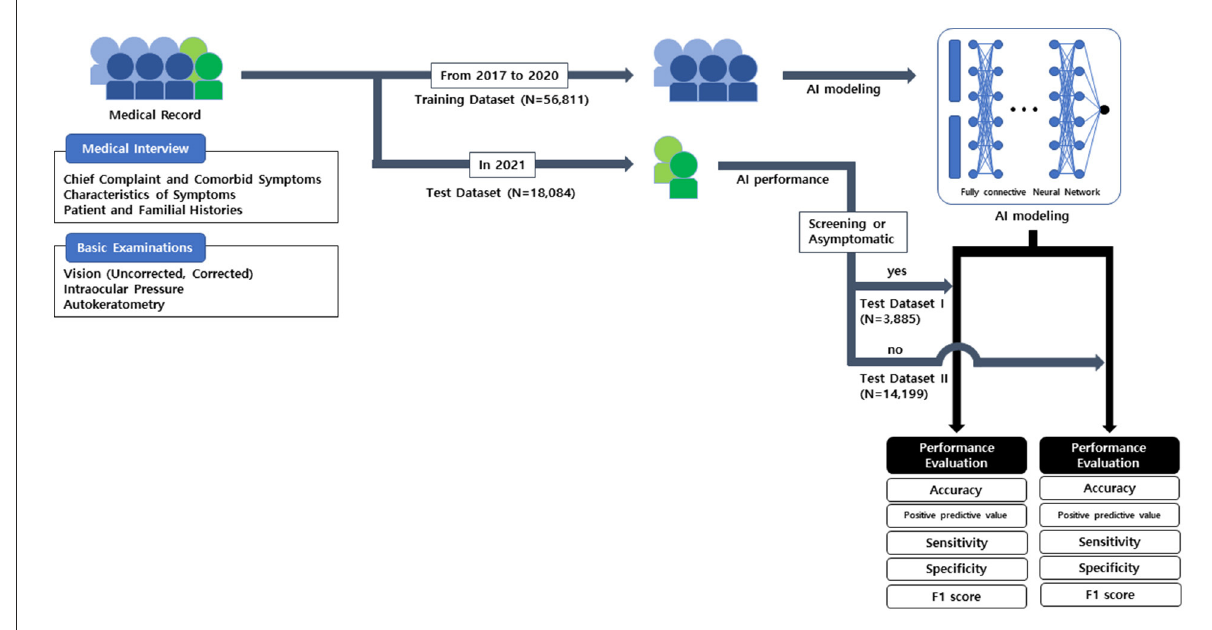
FIGURE2 The process used in this study and artificial intelligence modeling for recommending pupil dilation